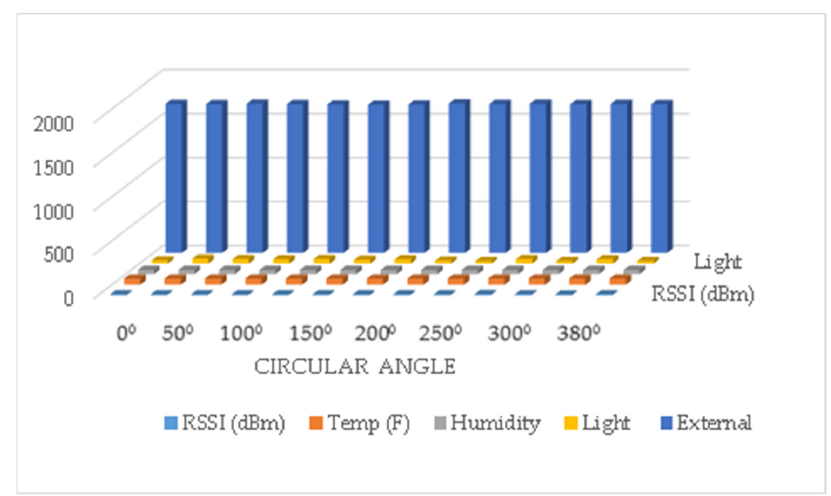
Figure 11. 340° Sense Data from Patch Antenna. Figure 11. 340 ◦ Sense Data from Patch